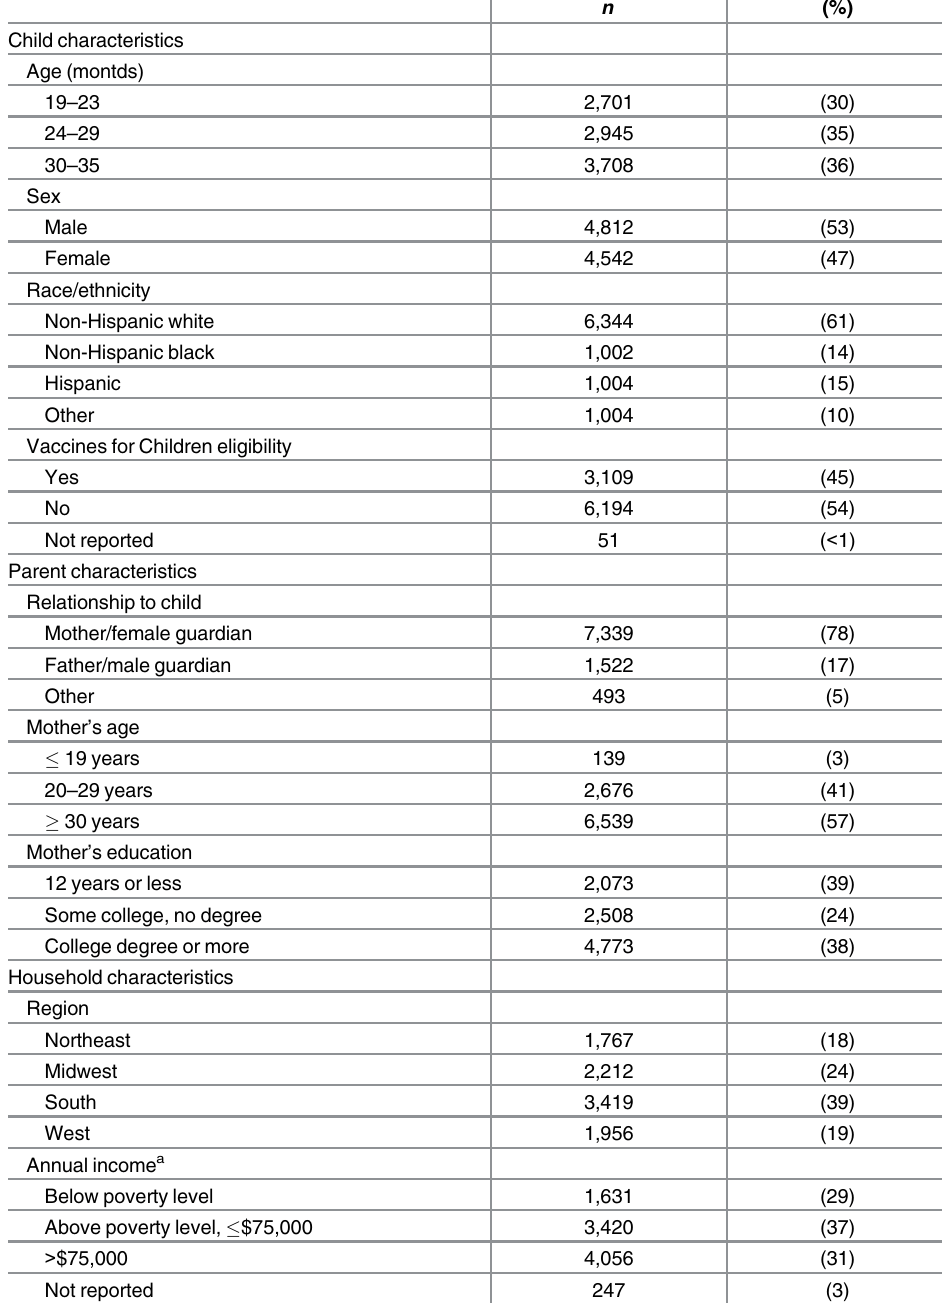
Table 1. Sample characteristics ( n = 9,354).